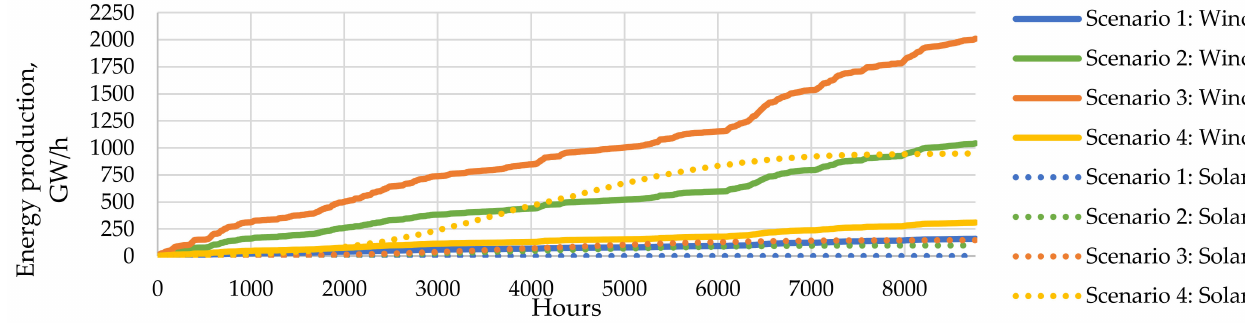
Figure 12. Annual accumulated VRE electricity production for different